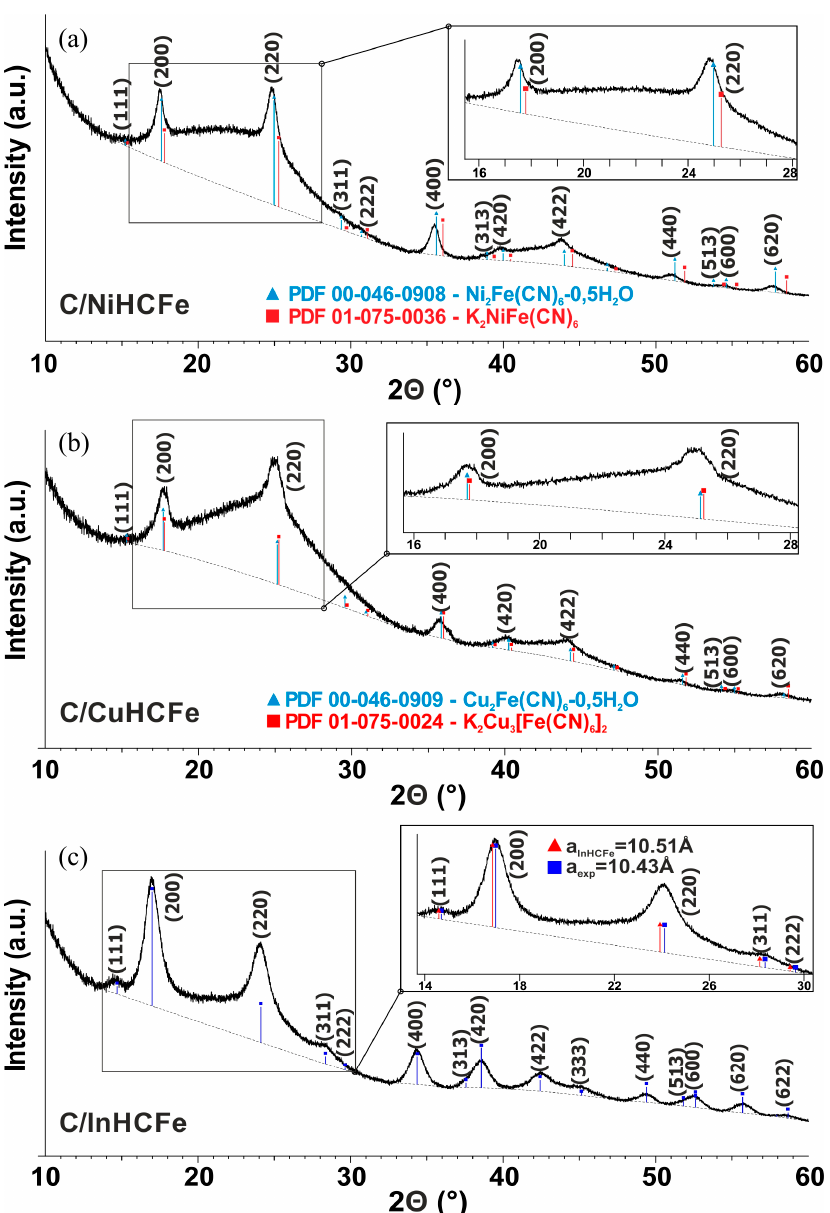
Figure 3. X-ray diffractrograms (CuK α 1,2 ) for C/NiHCFe ( a ), C/CuHCFe ( b ), and C/InHCFe ( c ). Background (default parameters for curvature and threshold in DIFFRAC.EVA) is the dotted line for each composite. Corresponding possible PDF patterns are indicated, the inserts allowed for a better view of details in the different pattern lines position with the most intense peaks (200) and (220). For the InHCFe phase, theoretical peaks positions were calculated from Reference [34] and then slightly shifted (unit cell parameter a near ≈ 10.43 Å).